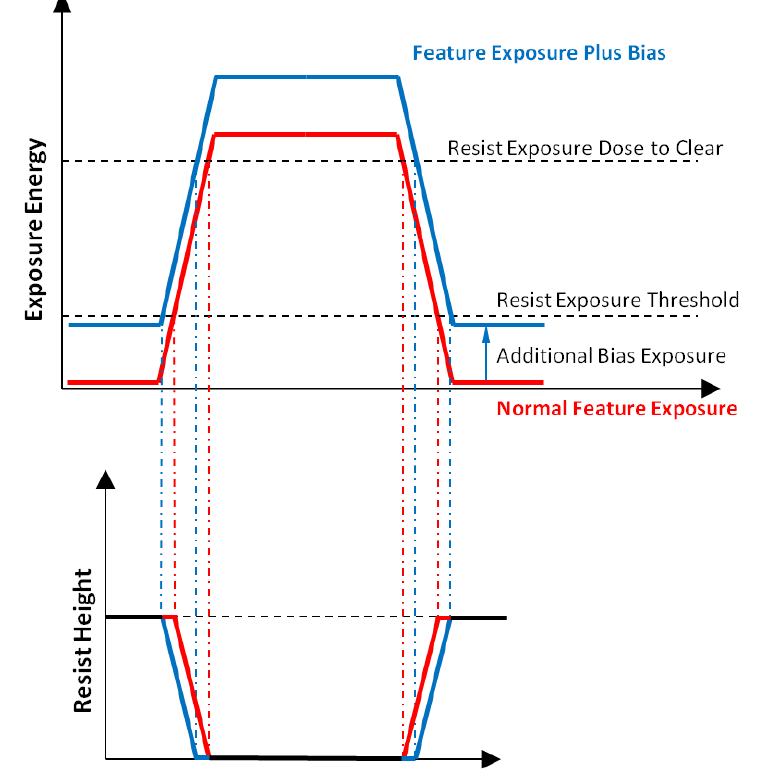
Figure 10. Diagram illustrating the principle behind hole size modulation.